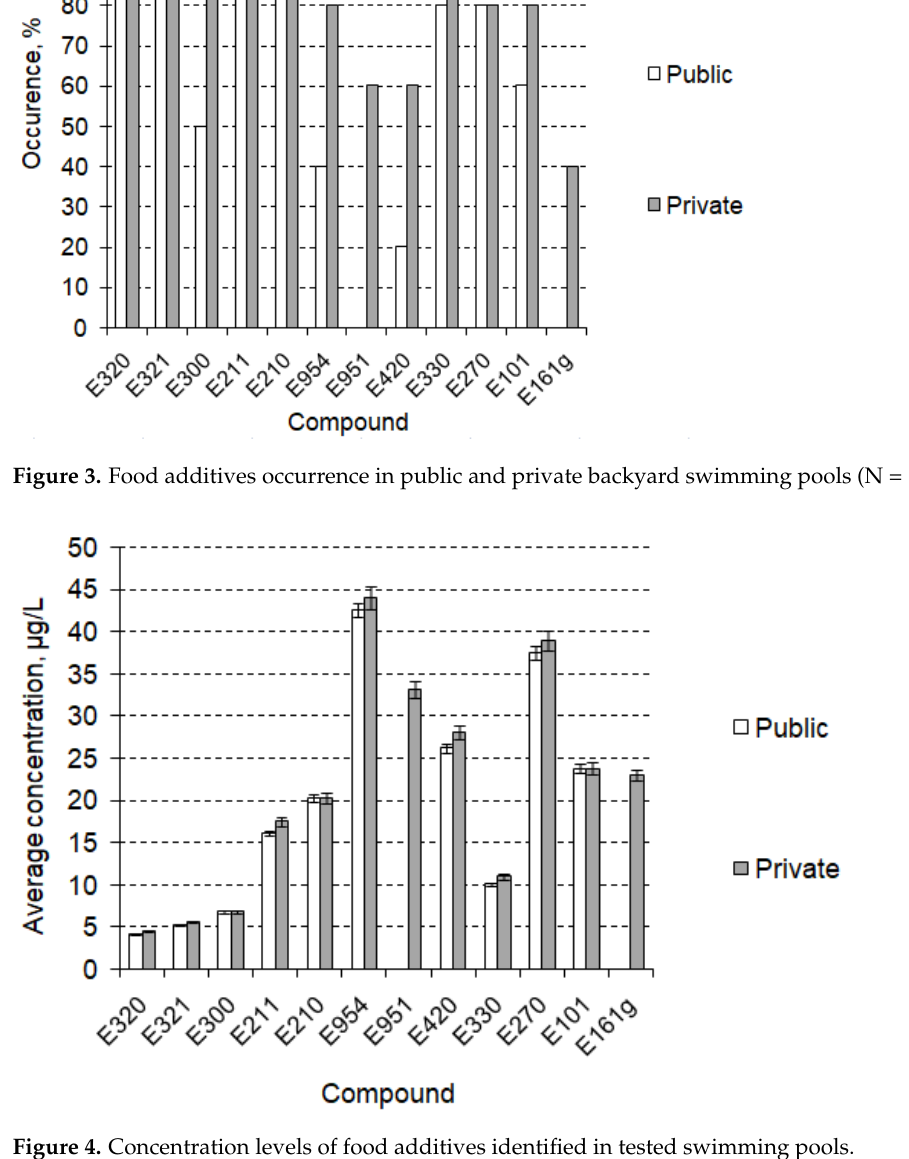
Figure 4. Concentration levels of food additives identified in tested swimming pools.